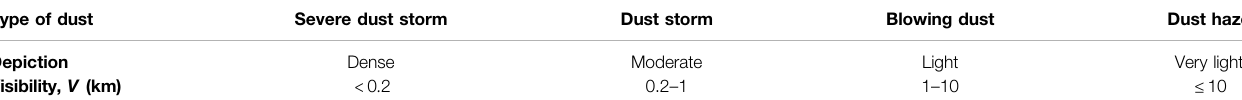
TABLE 1 | Dust storm classi fi cation established on a visibility basis.